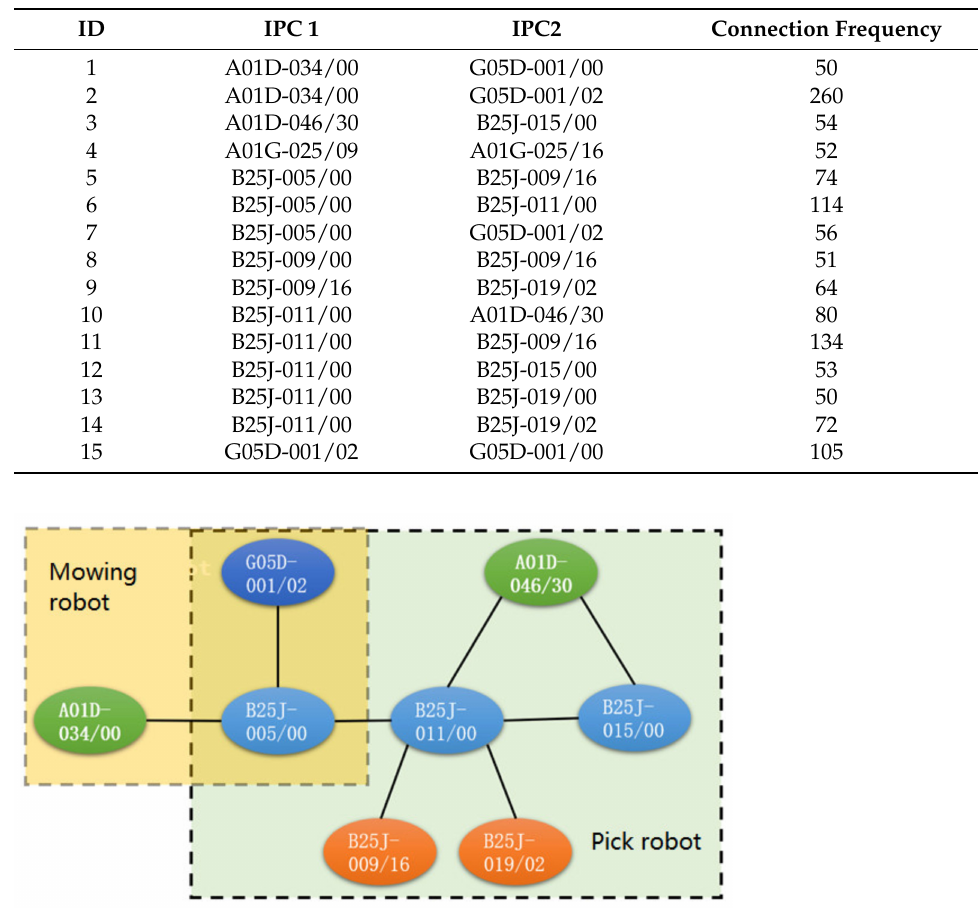
Table 2. The nodes with a connection frequency of more than 50 in the IPCNet.